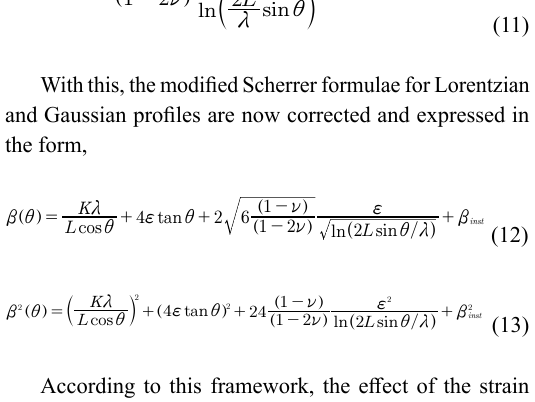
Figure 2. Profile of the XRD spectrum of the compound AgIn The lineshape of the diffraction peaks correspond in general to a Gaussian profile, as observed from the inserted figure.